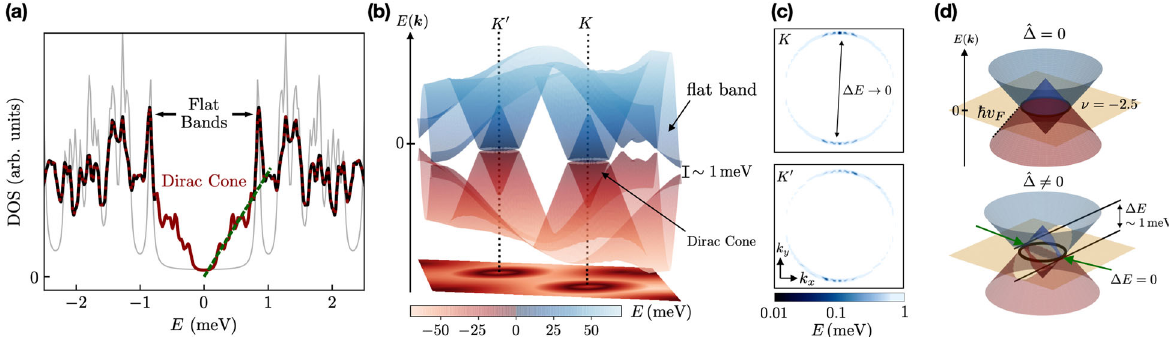
Fig. 3 Quasiparticle density of states (DOS) in the superconducting phase of MATTG for ν = − 2.5 and T = 0.2 K. a The density of states in q ffiffiffiffiffiffiffiffiffiffiffiffiffiffiffiffiffiffiffiffiffiffiffiffiffiffiffiffiffiffiffiffiffiffiffiffiffiffiffiffi that result in the DOS the superconducting state captures fermionic quasiparticle excitations with energies ± E n ; k (cid:3) ± ð ϵ n ; k (cid:2) μ Þ 2 þ j Δ n ; k j 2 being particle-hole (ph) symmetric. In the DOS of all layers (black line), we fi nd clear and separate features of the Dirac cone (highlighted by the red line) and the fl at bands: While the fl at bands are fully gapped on an energy scale of ~1 meV (black line), the Dirac cone leads to separate linear signatures ~ ∣ E ∣ (green dashed line) in the DOS. The partial DOS of the middle layer of MATTG (gray line) shows no contribution from the Dirac cone ’ s DOS ~ ∣ E ∣ but contains contributions of the fl at bands only. This is in agreement with the Dirac cone having dominant spectral weight in the outer layers, whereas the fl at bands dominate in the middle layer. b , c Quasiparticle energy landscape E ( k ) as a function of momentum in the Brillouin zone of MATTG. In the superconducting phase, the Dirac cones at K and K 0 each show two nodes in the quasiparticle spectrum re fl ecting the C 3 z symmetry breaking nature of the nematic superconducting phase in momentum space. These nodes become distinguishable by the dark blue regions in c indicating the vanishing gap amplitude ∣ Δ n , k ∣ → 0 as the quasiparticle energies approach E ( k ) → 0. d Schematic sketch of the Dirac cone in the normal state (upper panel) and superconducting phase (lower panel). In the non- interacting case ^ Δ ¼ 0 and at fi lling ν = − 2.5, the chemical potential (yellow plane) cuts the Dirac cone at energies higher than the Dirac point such that the tip of the Dirac cone is mirrored by ph-symmetry and the Fermi surface consists of a ring (black line). In the superconducting phase, the quasiparticle spectrum shows two nodes at this Fermi surface (green arrows) but is gapped away from these